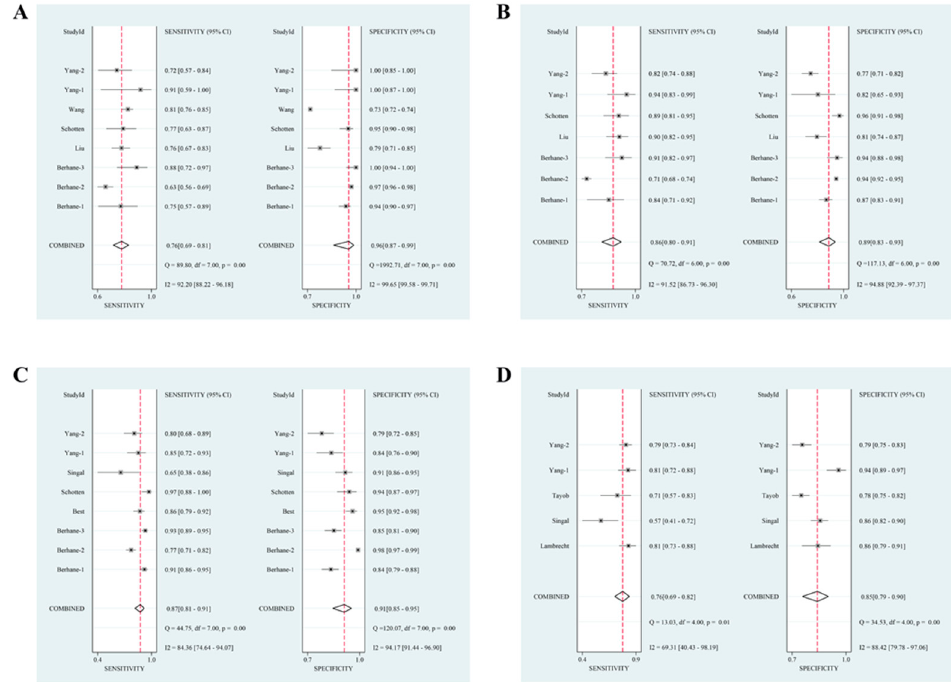
Figure 4. The pooled sensitivity specificity with Forest plots of GALAD score for discriminating hepatocellular carcinoma in patients with different etiologies. ( A ) Hepatitis B virus; ( B ) hepatitis C virus; ( C ) non-viral liver diseases; ( D ) cirrhosis.